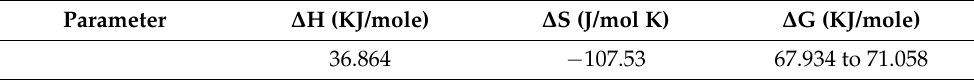
Table 3. Thermodynamic parameters of the adsorption process based on the Van’t Hoff plot. Parameter